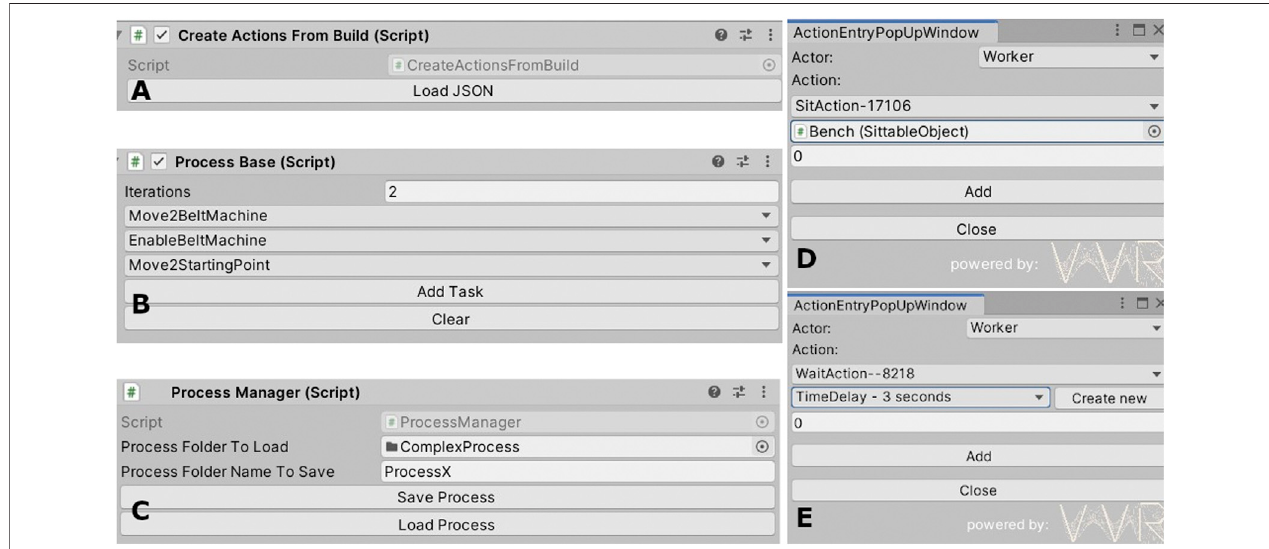
FIGURE6| ExamplesoftheGUI-basedauthoringtools forthesimulationmoduleinsideUnity3Dengine. (A) TheusercanloadtheJSON fi lethatwillautogenerate the training task. (B) Task modi fi cation is a possible option for the user to experiment. (C) Processes can be saved and loaded afterwards. (D and E) Examples of “ action ”